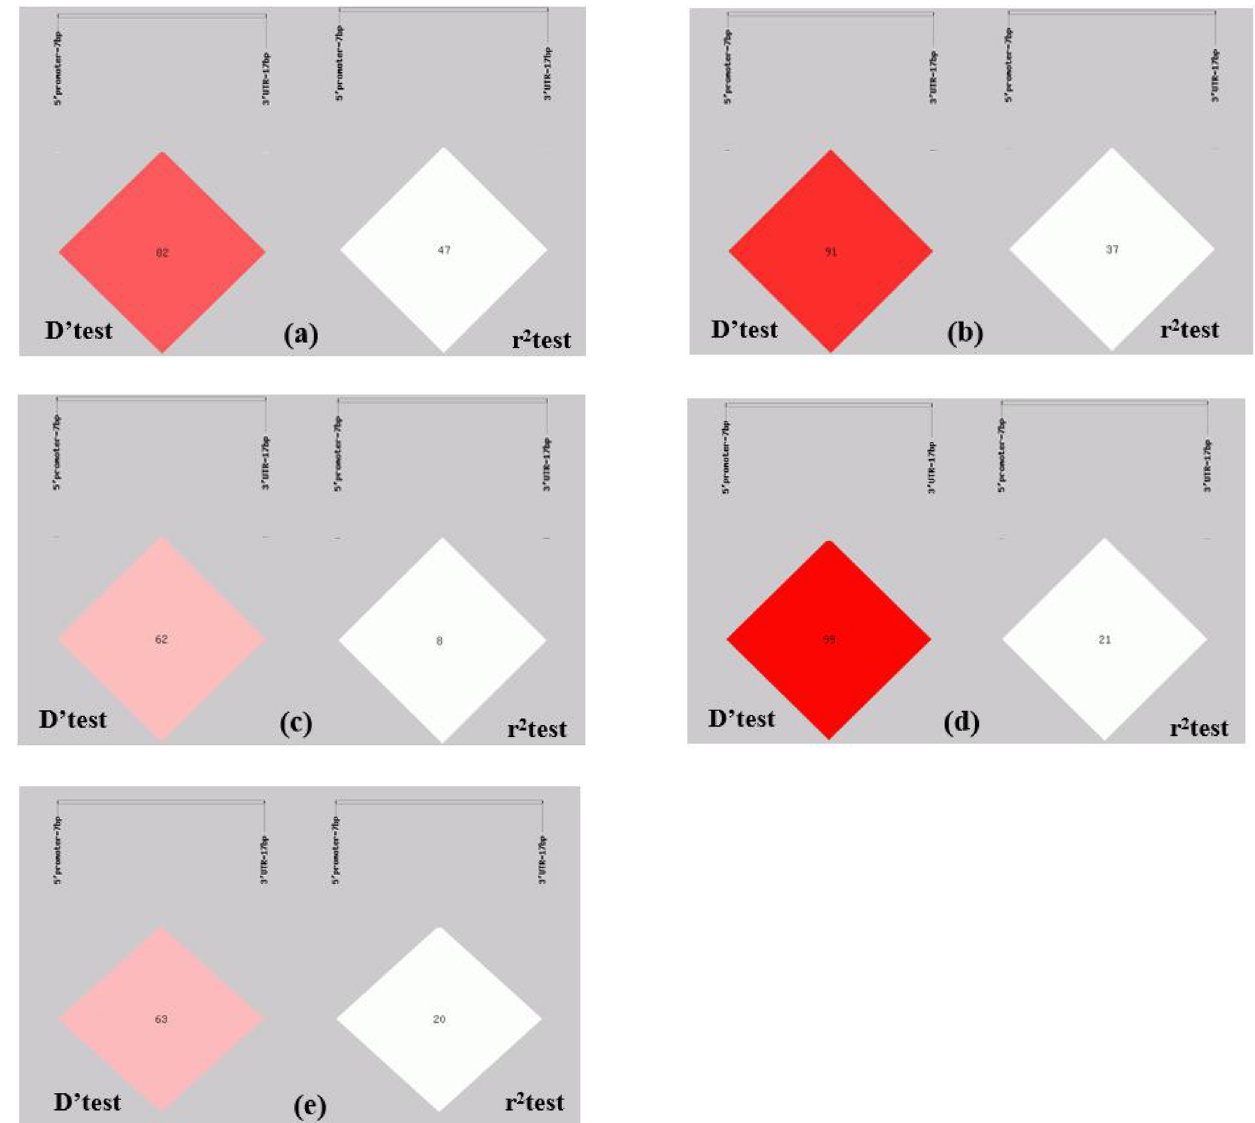
Figure 2. Linkage equilibrium test of two pairs of alleles within the ovine SIRT7 gene in different populations: (a) Lanzhou fat-tail sheep, (b) small-tail Han sheep, (c) Tong sheep, (d) Hu sheep, and (e) Sartuul sheep. Note: the 5 (cid:48) promoter region-insertion-7bp (loci1) and 3 (cid:48) UTR-insertion-17bp loci (loci2) were chosen for haplotype